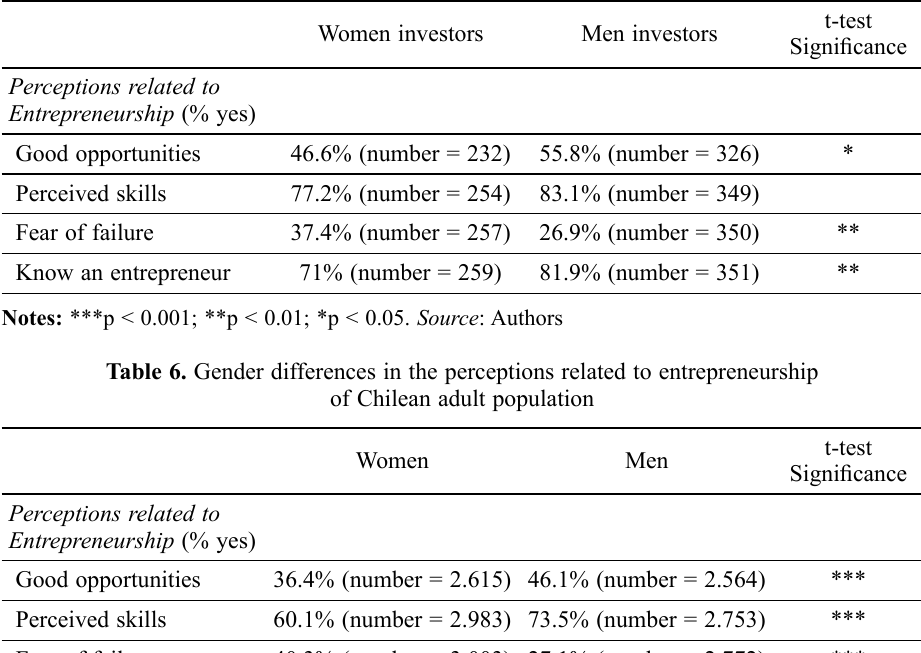
Table 5. Gender differences in the perceptions related to entrepreneurship of informal investors